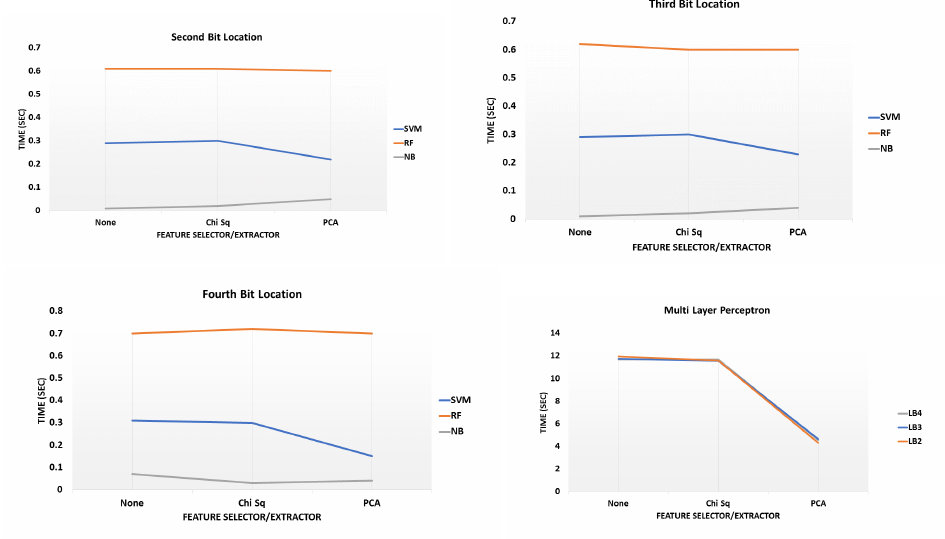
Figure 11. Timing Results for model building for LB2, LB3 and